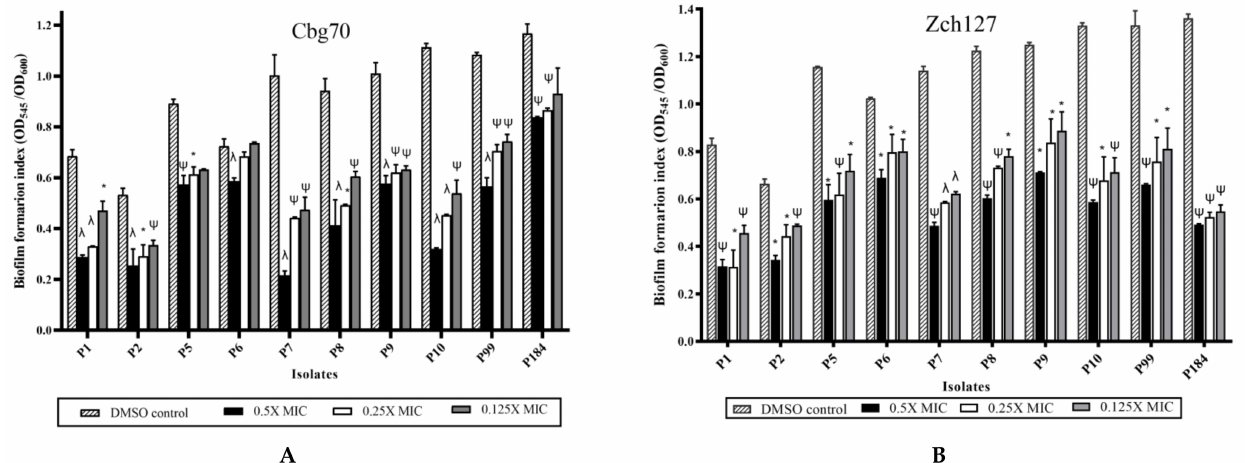
Figure 3. Inhibitory effect of Enterobacter sp. culture supernatant on biofilm formation of P. mirabilis isolates. Average biofilm formation index of P. mirabilis isolates following treatment with sub- MICs of the indole extracts: DMSO control (striped bars), at 0.5X MIC (black bars), 0.25X MIC (white bars), and 0.125X MIC (grey bars): ( A ) Culture supernatant of extract Cbg70 at concentrations ranging from (20 to 80 µ g/mL), ( B ) Culture supernatant of extract Zch127 at concentrations ranging from (0.15 to 0.6 mg/mL) , Data represents the mean of at least 3 biological replicates, and error bars show standard error of the mean. Statistically difference was determined by student’s t -test * p < 0.05; ψ p < 0.01; λ p < 0.001 compared with DMSO